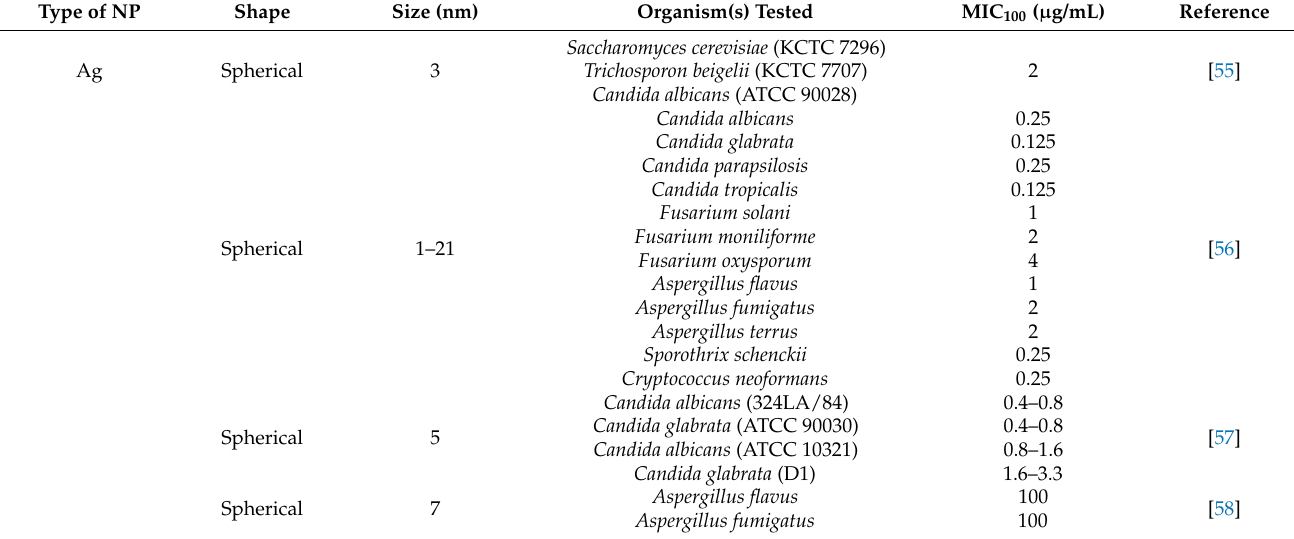
Table 1. Activities of NPs tested on different fungal species expressed in MIC 100 ( µ